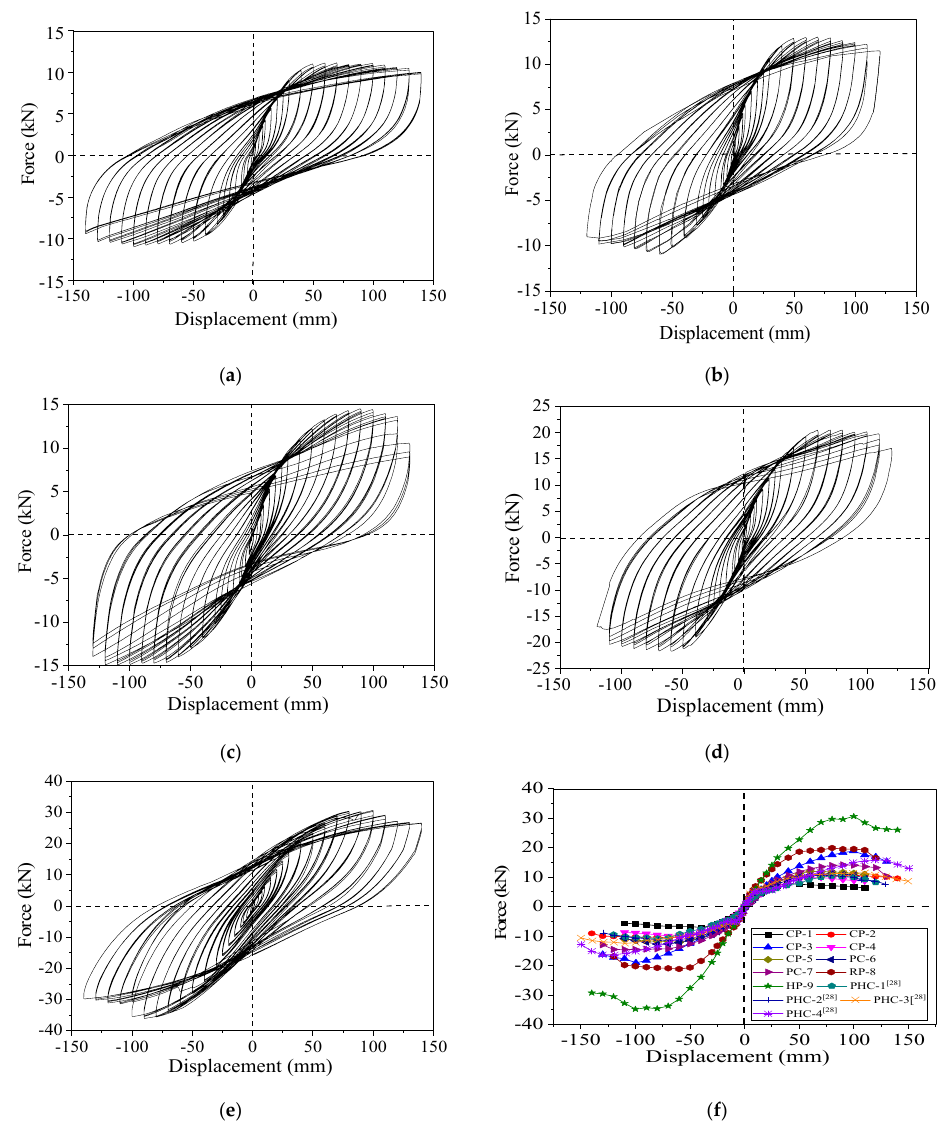
Figure 17. Hysteresis and backbone curves. ( a ) Hysteresis loops of CP-2 specimen. ( b ) Hysteresis loops of CP-5 specimen. ( c ) Hysteresis loops of PC-6 specimen. ( d ) Hysteresis loops of RP-8 specimen. ( e ) Hysteresis loops of HP-9 specimen. ( f ) Backbone curves of all